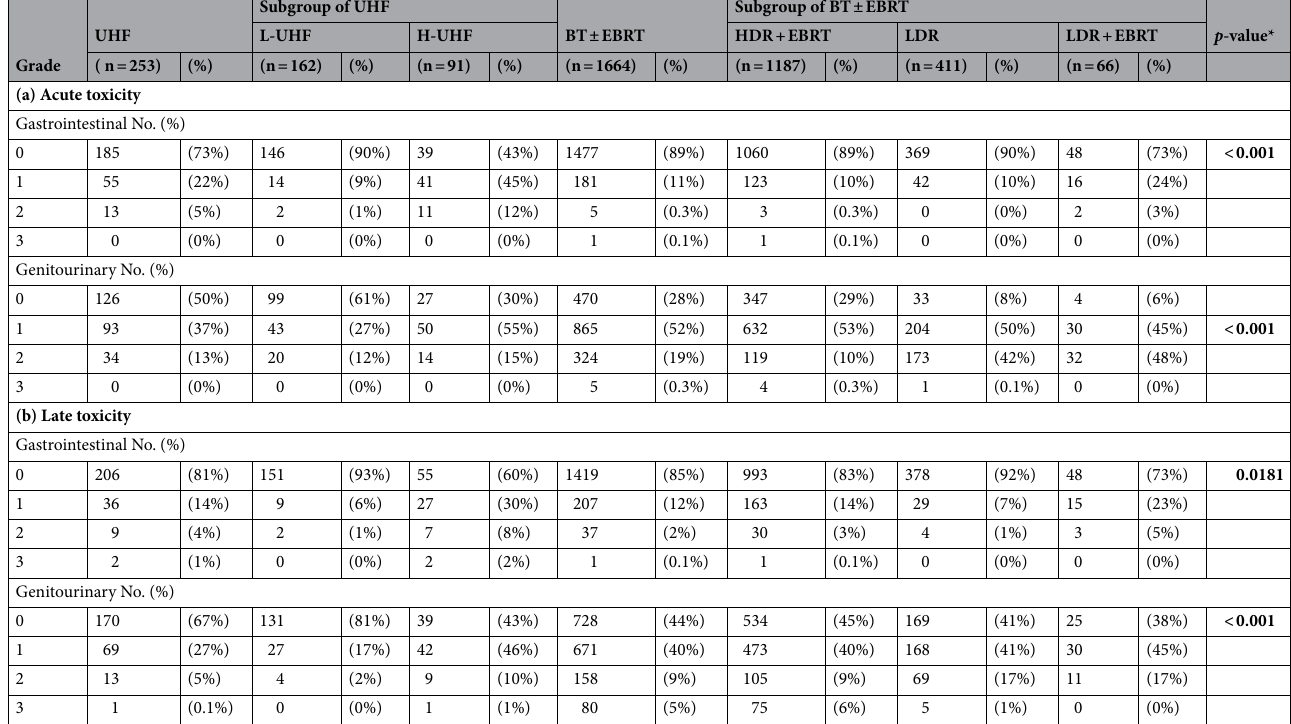
Table 3. Comparison of toxicity grade between UHF and BT. BT brachytherapy, EBRT external beam radiotherapy, UHF ultrahypofractionated radiotherapy, HDR high-dose-rate, LDR low-dose-rate,